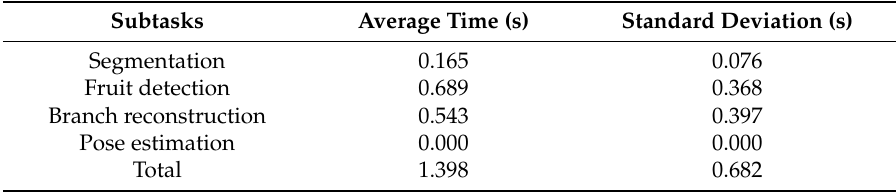
Table 5. Real-time performance for the proposed algorithm over the test